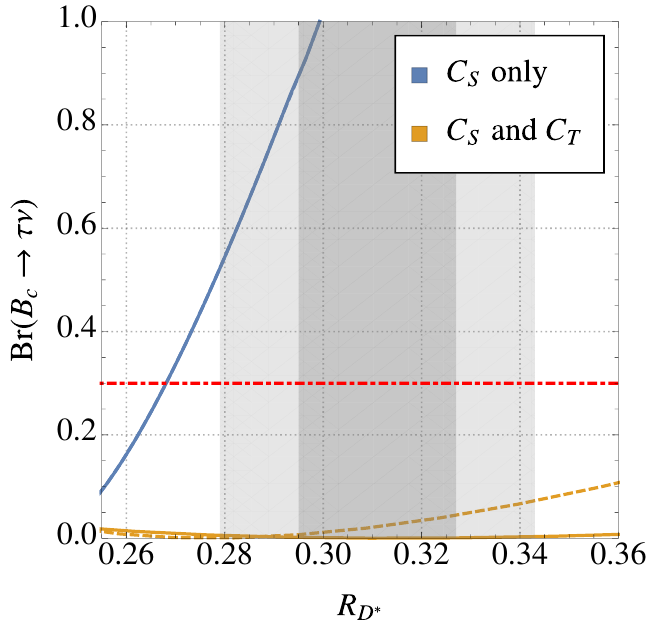
! (cid:28)(cid:23) ) against R with new physics only in C (solid blue) c D (cid:3) S and C satisfying C = (cid:0) 4 (solid orange) and C = (cid:0) 7 : 8 S T S =C T S =C T . In this leptoquark model, Br( B ! (cid:28)(cid:23) ) remains SM-like c D ( (cid:3) )